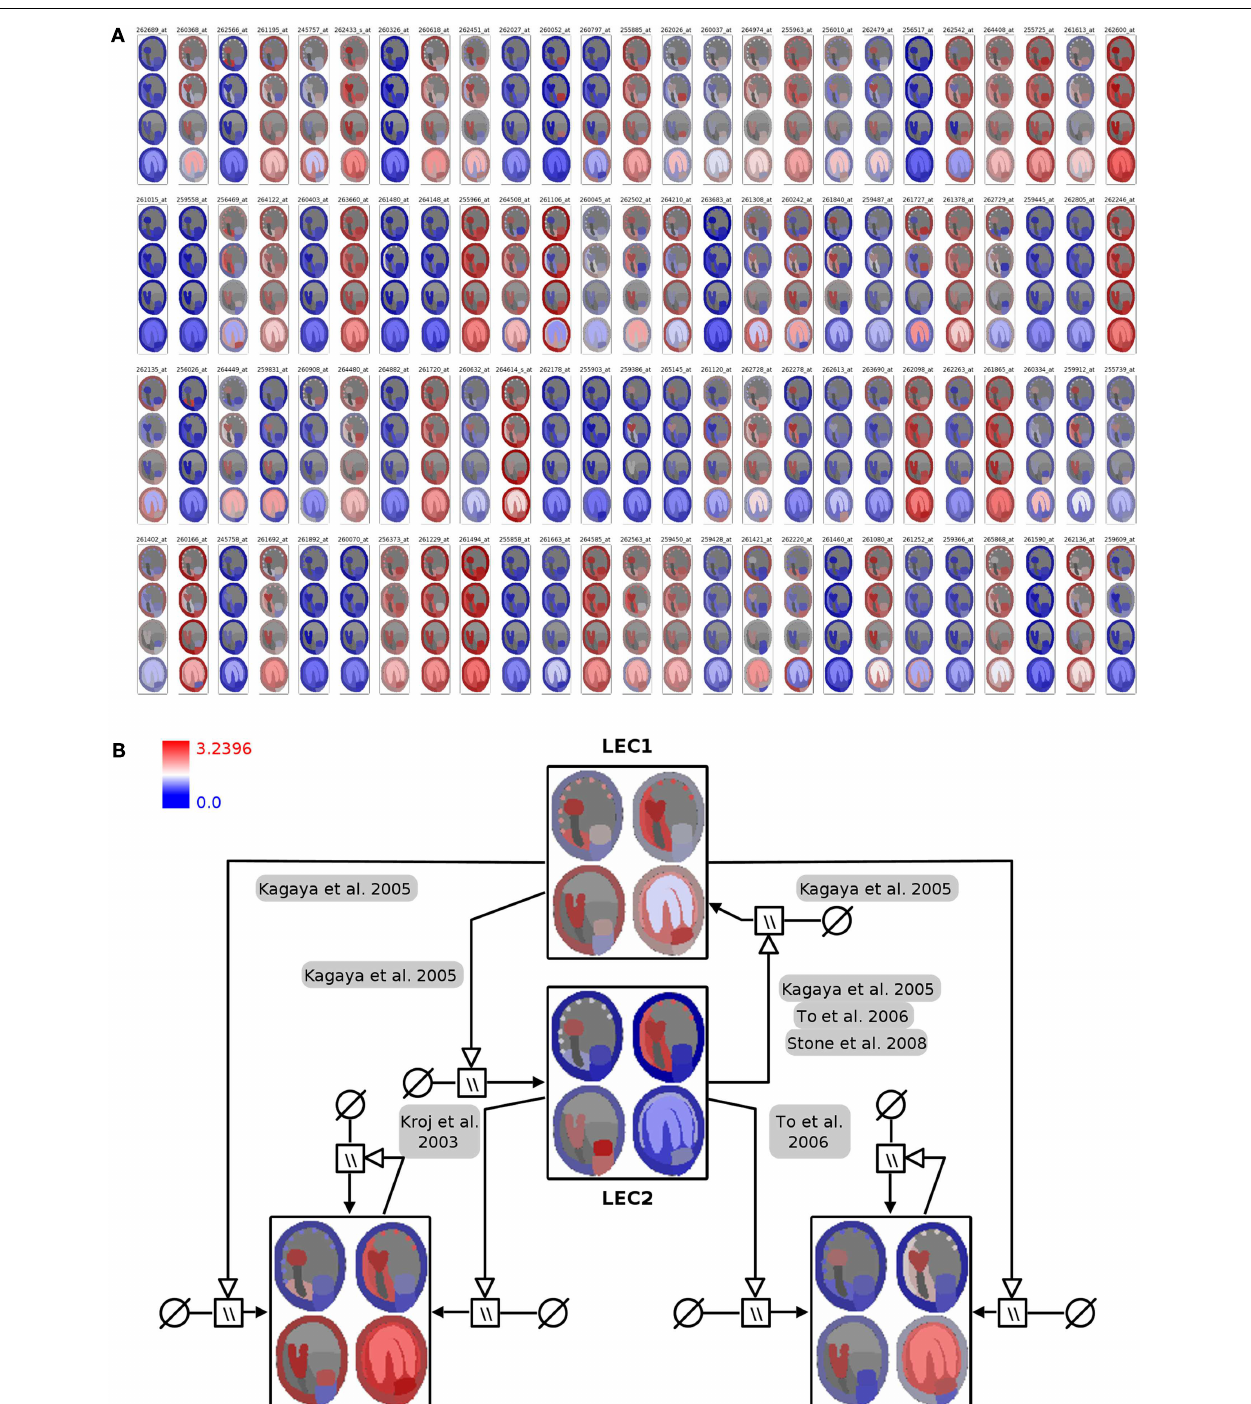
FIGURE 4 |Visualization of seed regulator expression profiles with spatio-temporal resolution in the context of the seed anatomical structure and gene-regulatory network. (A) Seed expression profiles of 100 Arabidopsis genes with regulatory functions, using 2D seed images for display of the corresponding spatio-temporal resolution (red: high expression; blue: low expression). (B) Integration of color-coded seed images into the LEC1/AFLB3 regulatory network. LEC1 seems to function upstream of LEC2, FUS3, and ABI3 (Meinke et al., 1994; Kagaya et al., 2005;To et al., 2006;